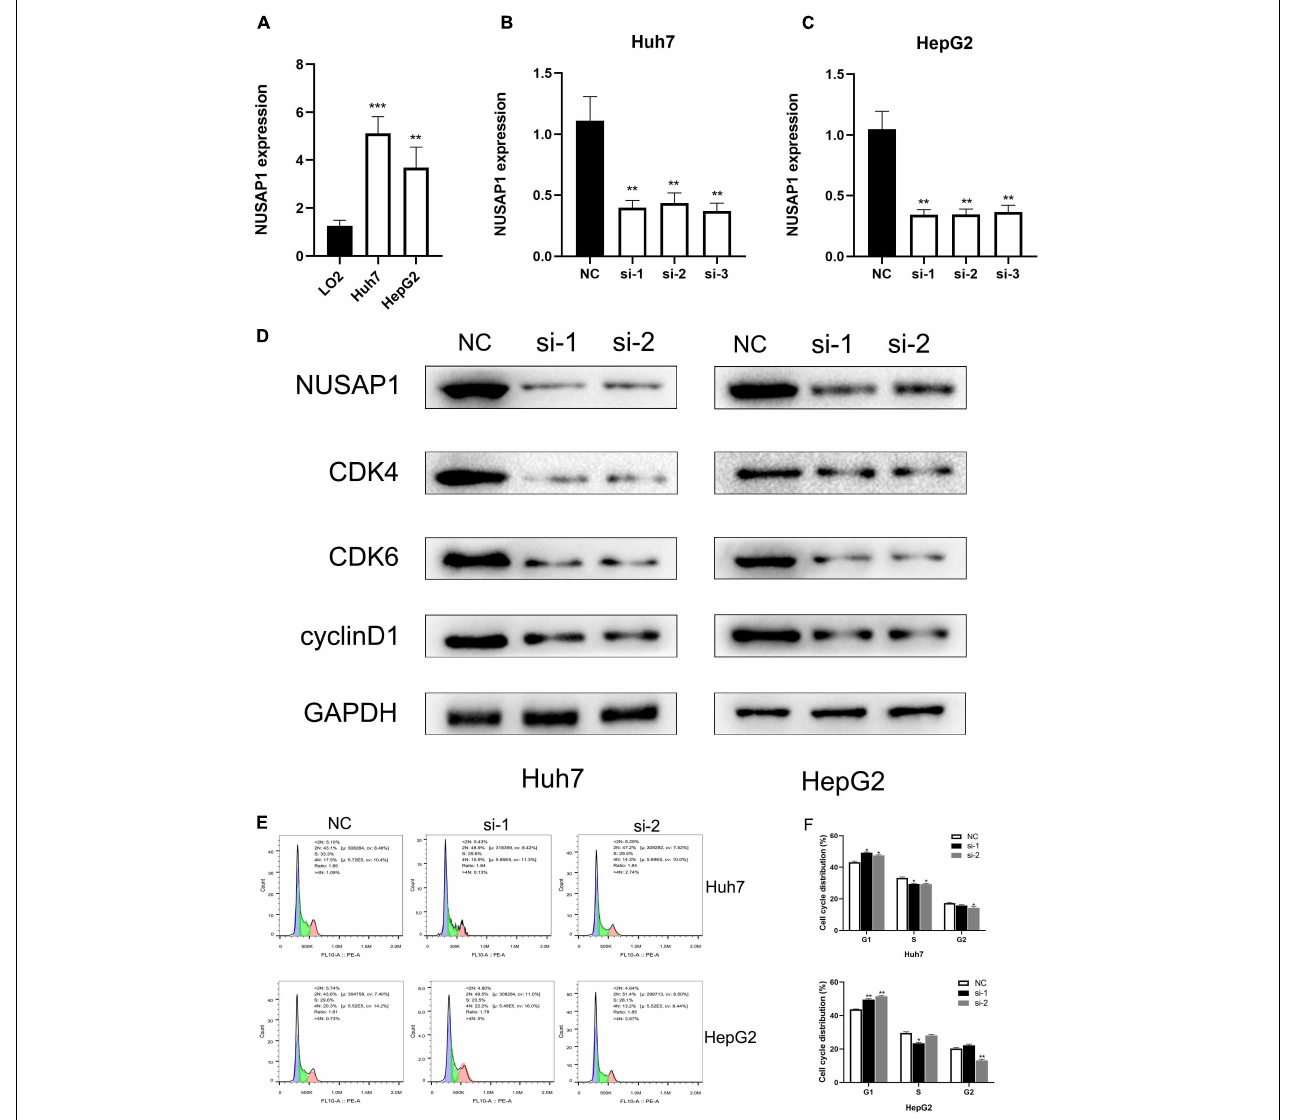
FIGURE 8 | qRT-PCR, Western blot, and flow cytometry. (A) Bar graph of qRT-PCR, which was used to examine NUSAP1 expression level in normal human hepatic cell line LO2, HCC cell line Huh7, and HCC cell line HepG2. (B) Bar graph of qRT-PCR, which was used to examine NUSAP1 expression level among NC control group, si-1 treatment group, si-2 treatment group, and si-3 treatment group in Huh7 cell line. (C) Bar graph of qRT-PCR, which was used to examine NUSAP1 expression level among NC control group, si-1 treatment group, si-2 treatment group, and si-3 treatment group in HepG2 cell line. (D) Western blot was performed to measure the expression of CDK4, CDK6, and cyclinD1, which were crucial protein for regulating G1 to S phase transition. (E) Flow cytometric analysis of cell cycle distribution in HepG2 and Huh7 cell lines treated with siNUSAP1. (F) By comparing with NC group, si-1 and si-2 groups increased cell cycle arrest at the G1 phase. * P < 0.05; ** P < 0.01; *** P <